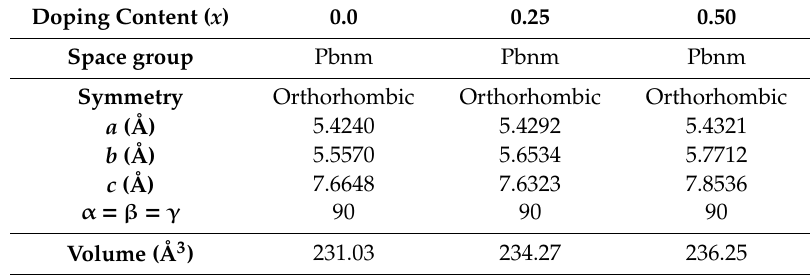
Table 1. Lattice parameters a , b and c , and cell volume, V , of Nd 1 − x Bi x MnO 3 samples.